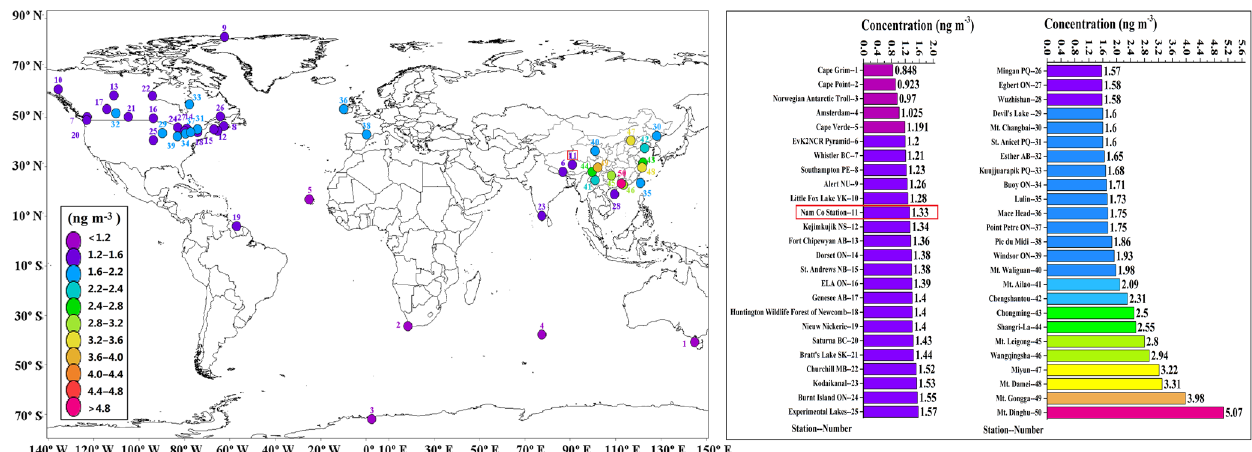
Figure 1. Geographical location of the remote and rural sites with atmospheric mercury